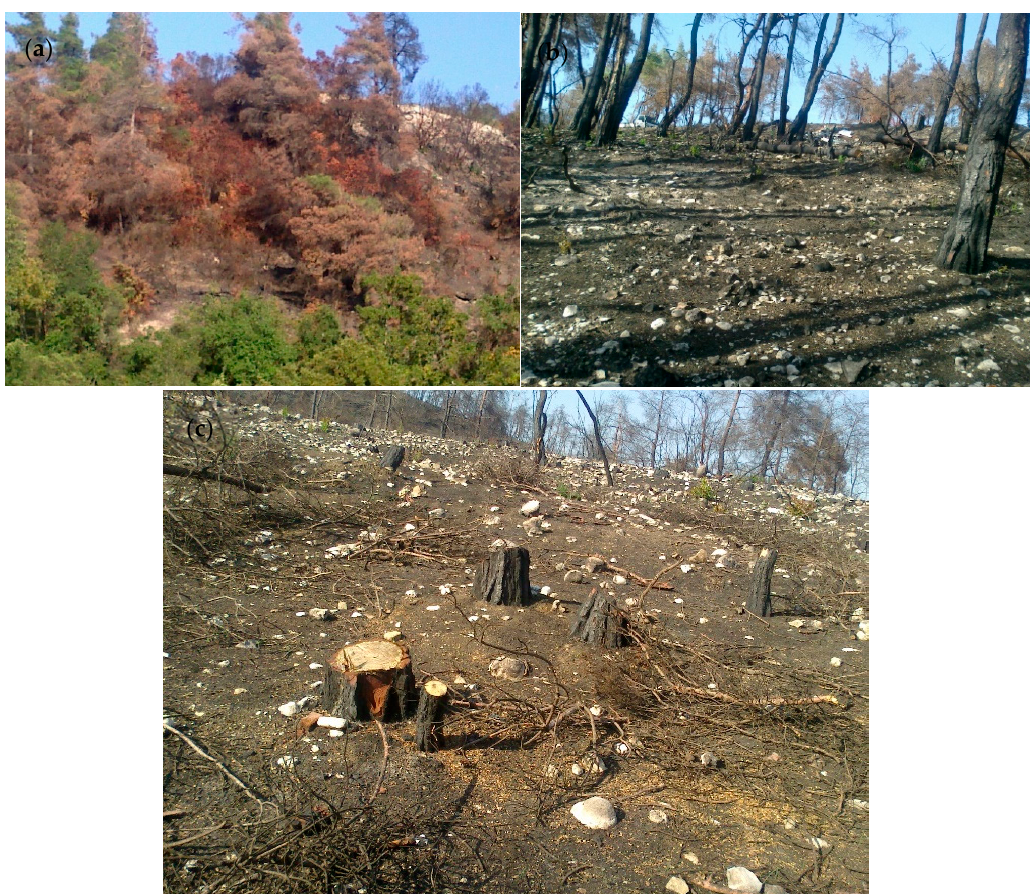
Figure 7. Photos of burned forests of Pinus brutia Ten. in upstream river ( a , b ) burned forest by bombing and ( c ) wood Logging after the forest was burned.